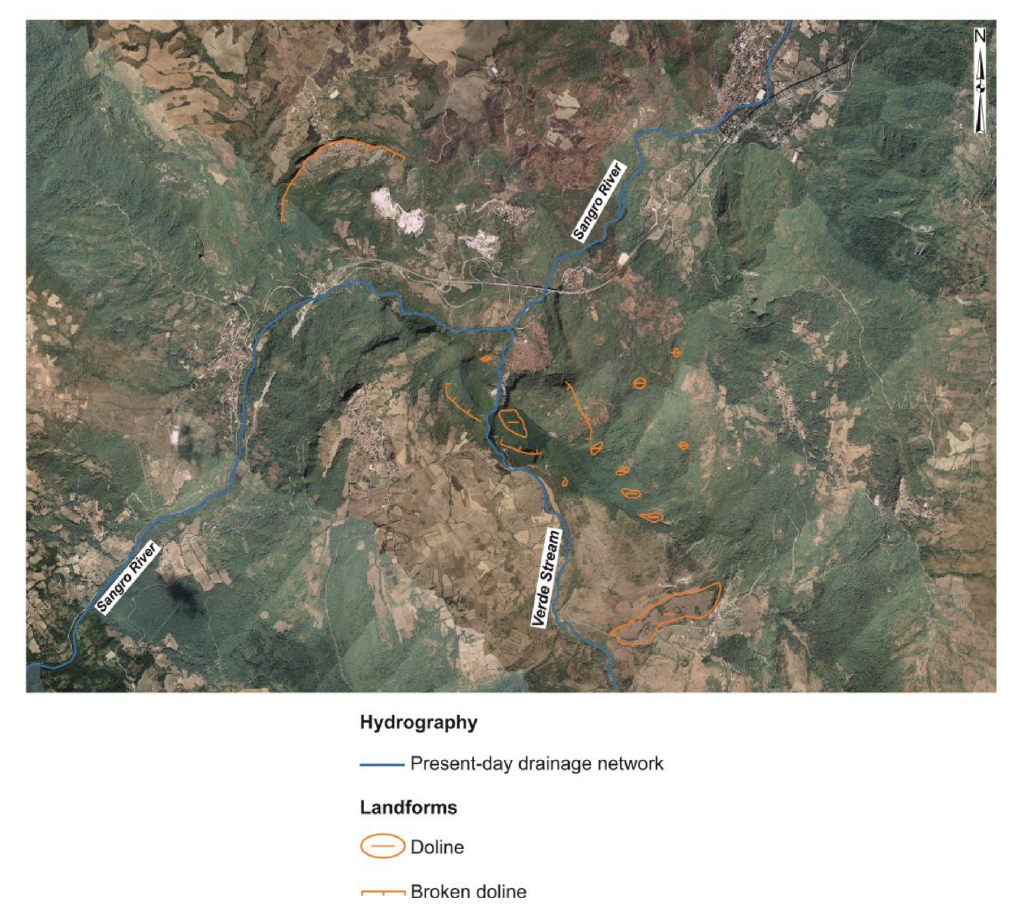
Figure 17. General framework of karst landforms in the Verde Stream–Sangro River junction area (provided by Abruzzo Region